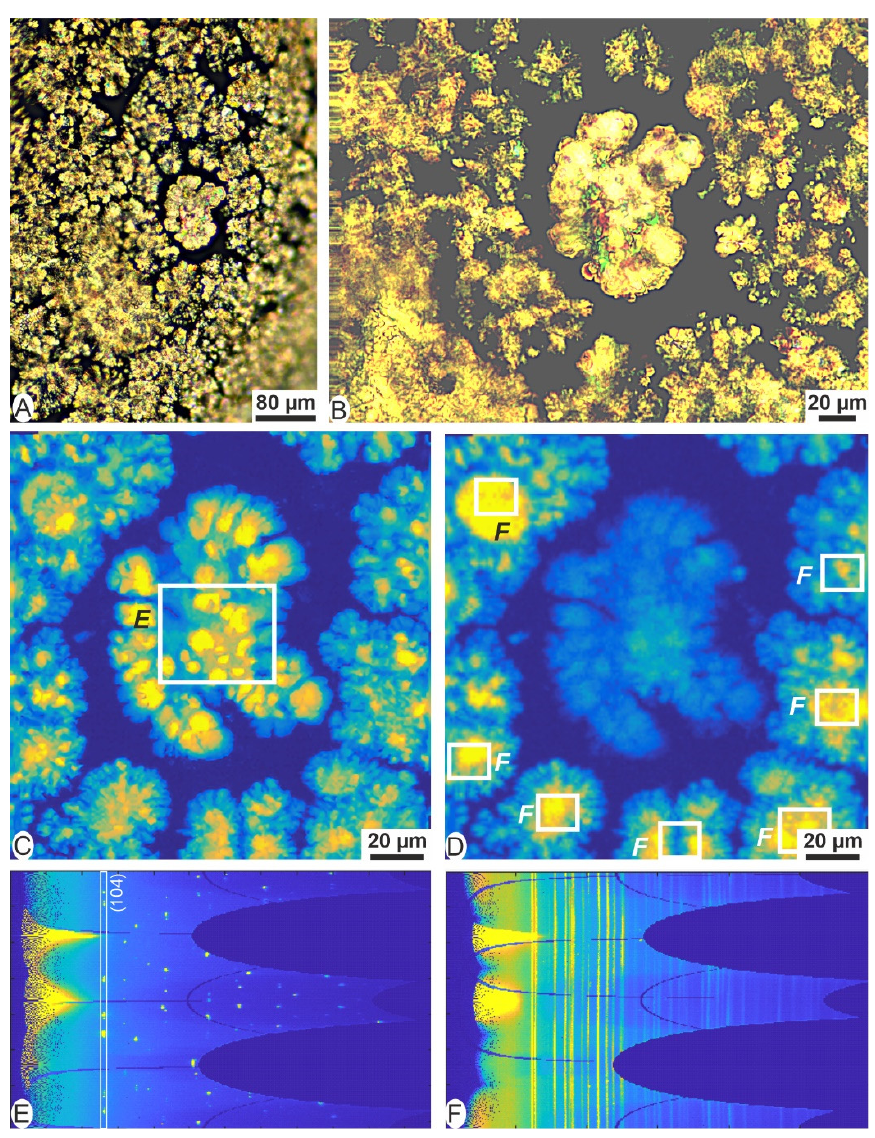
Figure 4. Mineralizing spots in which the distinct physical status of calcite and aragonite are estab ‐ lished. ( A , B ) Natural view of the area. ( C , D ) High ‐ resolution X ‐ ray fluorescence for calcium ( C ) and strontium ( D ). ( E , F ) Diffraction diagrams for the central ( E ) and lateral ( F ) areas. Well crystallized calcite ( E : distinct diffraction spots) and powder aragonite ( F : small spots in continuous lines) are characterized in neighbor areas produced by the same pearl sac.